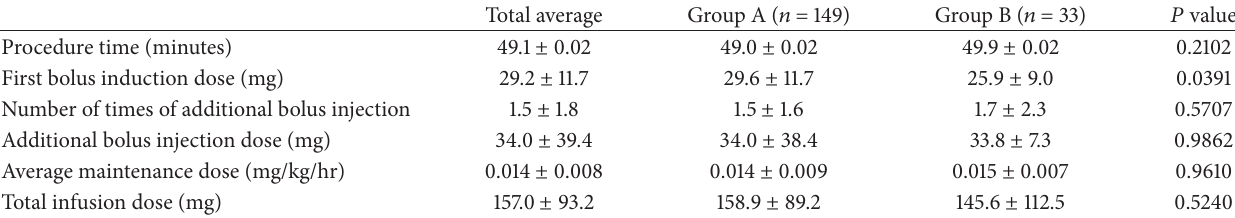
Table 3: Details of propofol